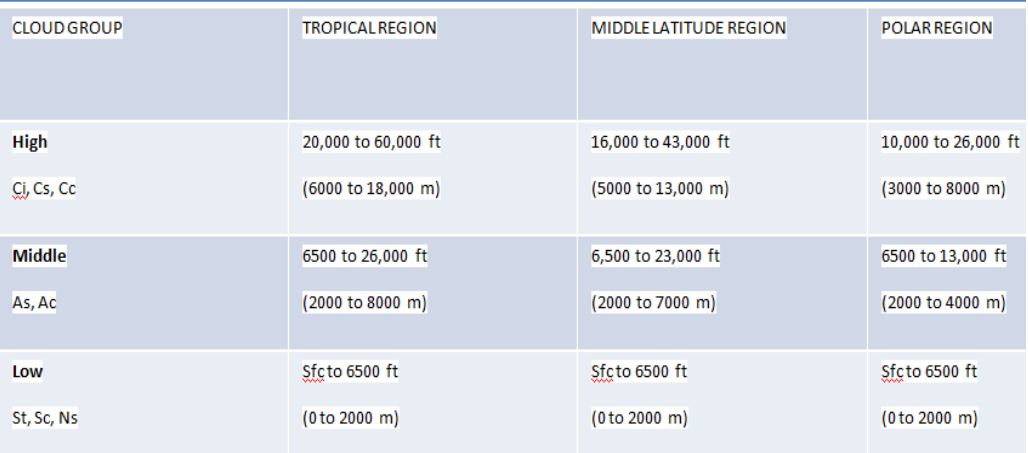
Table 2: The heights and types of clouds [6].